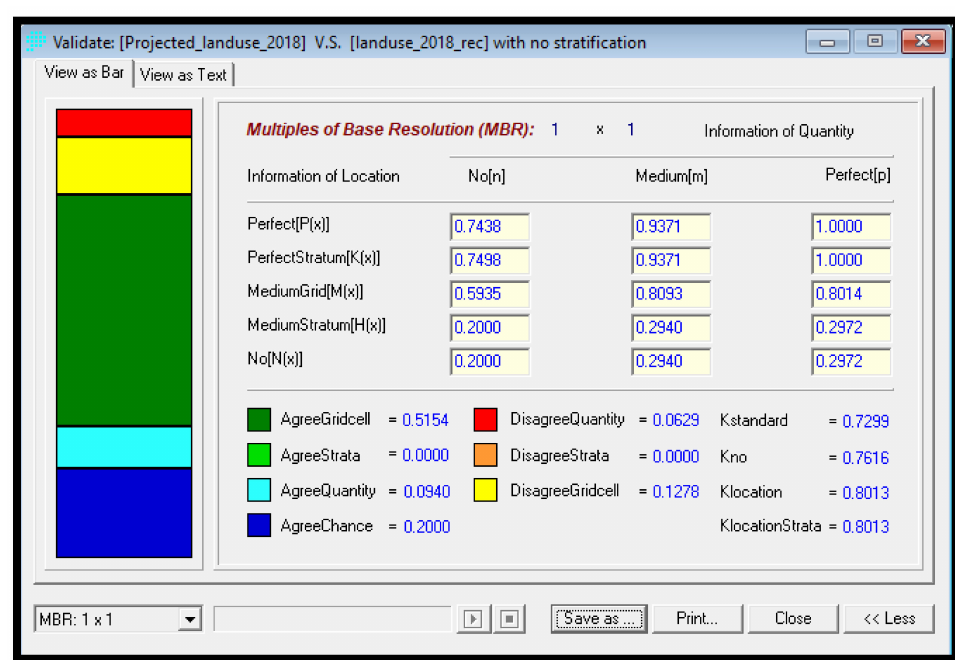
Figure 5. Validation of CA-Markov model.